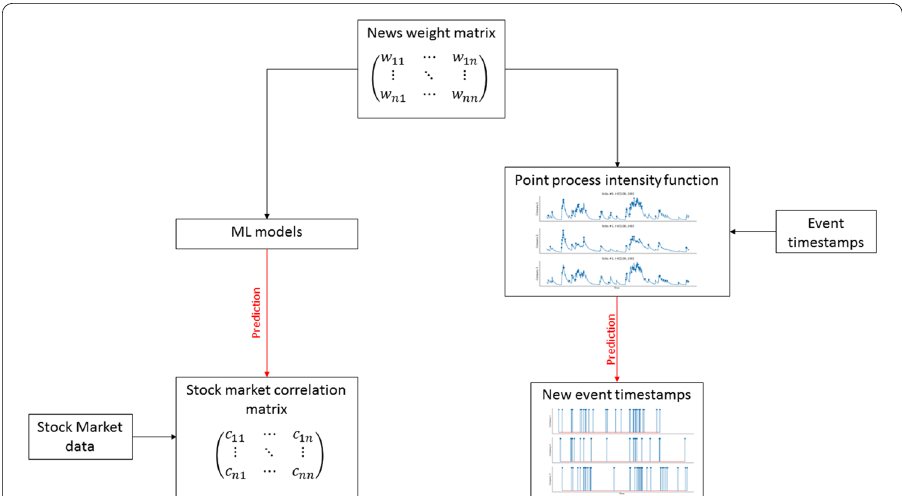
Fig. 3 Possible uses of news weight matrix for